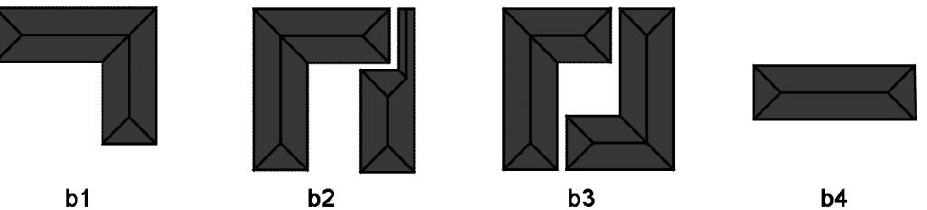
Table 1. Components of building exterior and form elements of Hanok. Figure 5. Layout types (B) Reprinted/adapted with permission from Ref. [3]. 2018, Donghwa Shon: Depending on the layout of the main house and gate building, the plan and facade of the Hanok